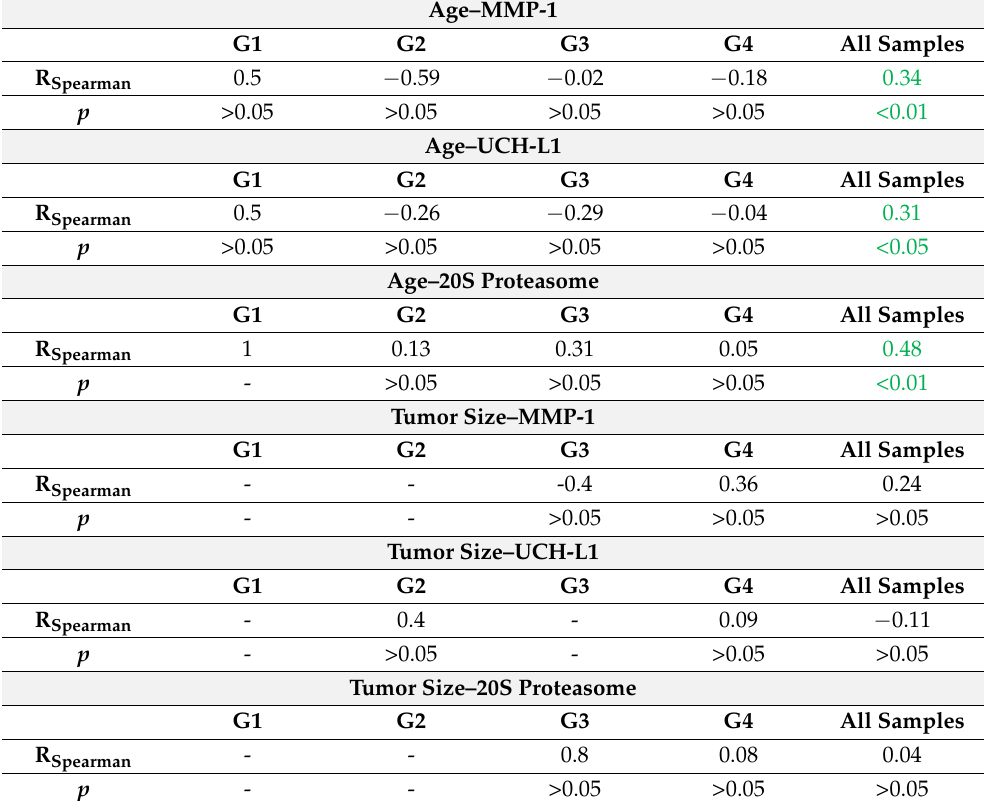
Table A4. Correlations: protein concentration–patient’s age and protein concentration–tumor size.